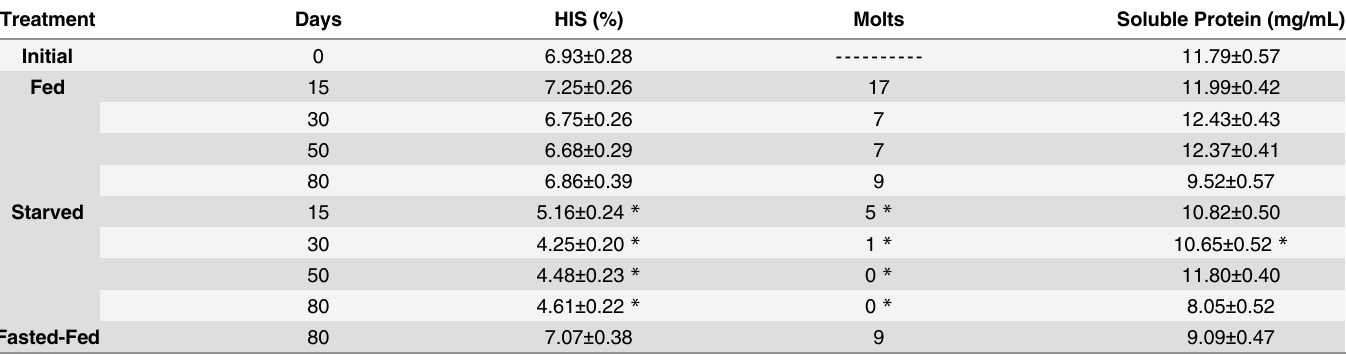
The statistical analysis was done among treatments at each experimental time. * indicates signi fi cant differences (p < 0.05).